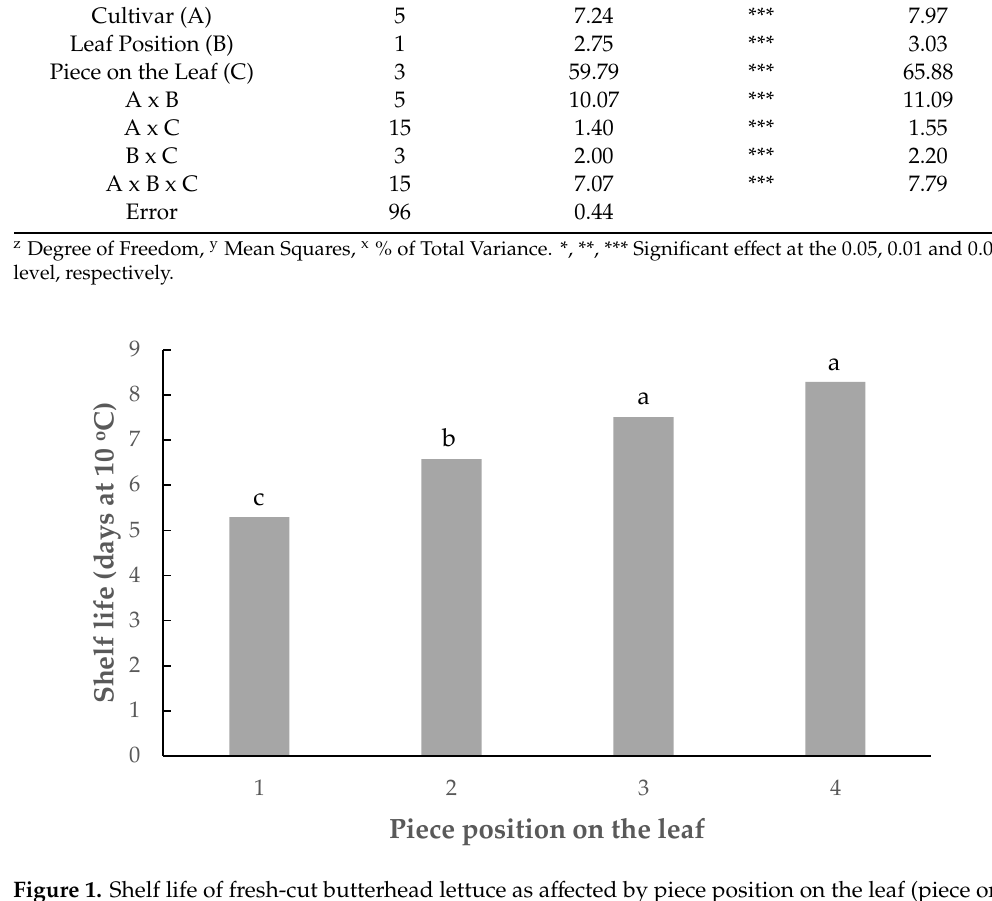
Figure 1. Shelf life of fresh-cut butterhead lettuce as affected by piece position on the leaf (piece one close to the leaf base and piece four close to the top), as an average of 6 cultivars and 2 leaf positions. Columns with different letters are significantly different ( a < 0.05).